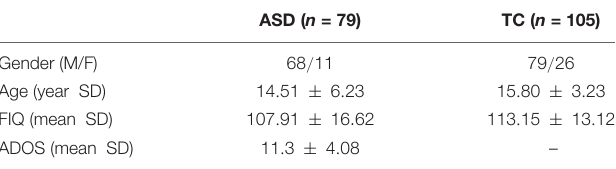
TABLE 1 | Demographic information of the used